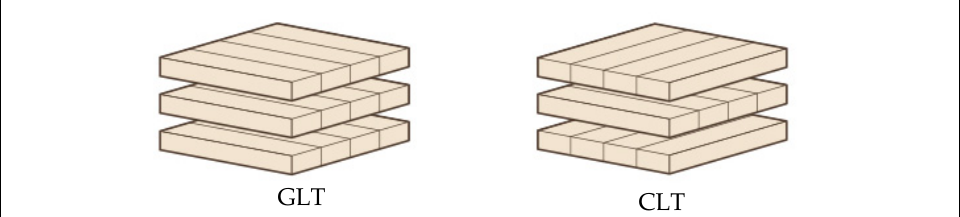
Figure 1. Bond directions in mass timber products, GLT and CLT [28] .